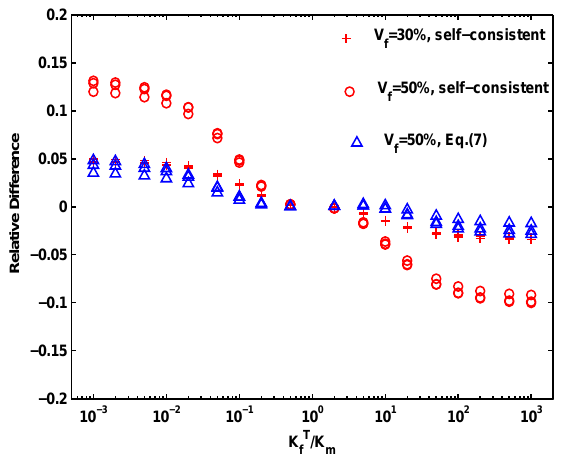
Figure 4. Comparison of the finite element results for effective thermal conductivity of the material systems composed of fiber and matrix with the analytical solution of the self-consistent (Equation (6)) and the fitted (Equation (11)) equations.